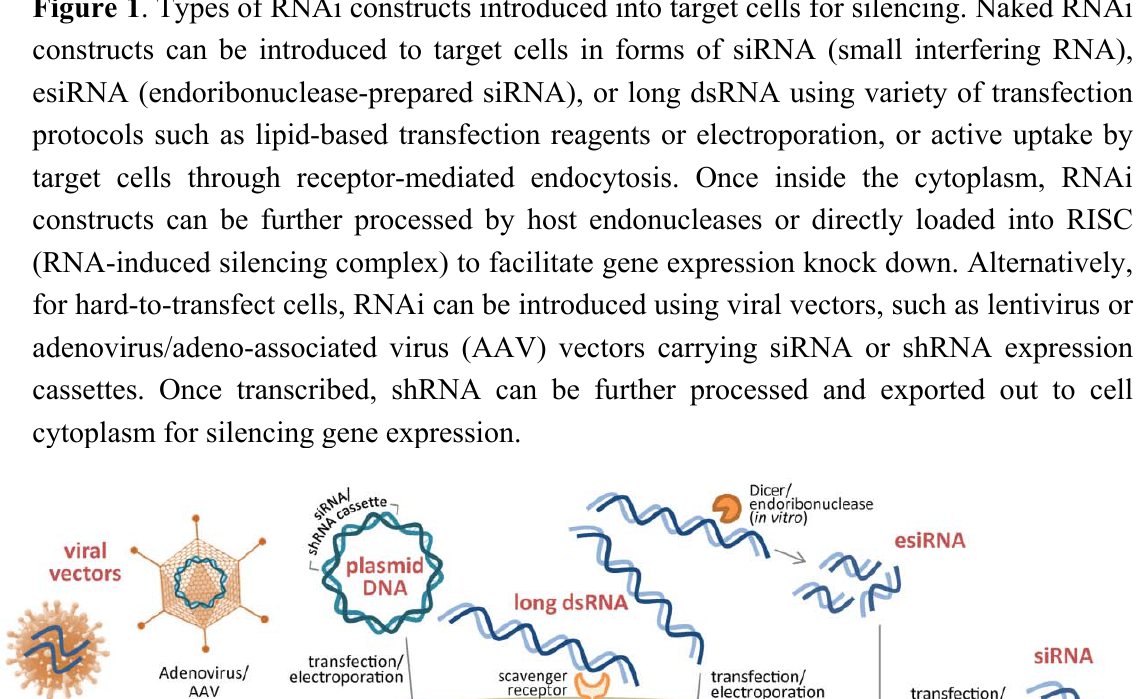
Figure 1 . Types of RNAi constructs introduced into target cells for silencing. Naked RNAi constructs can be introduced to target cells in forms of siRNA (small interfering RNA), esiRNA (endoribonuclease-prepared siRNA), or long dsRNA using variety of